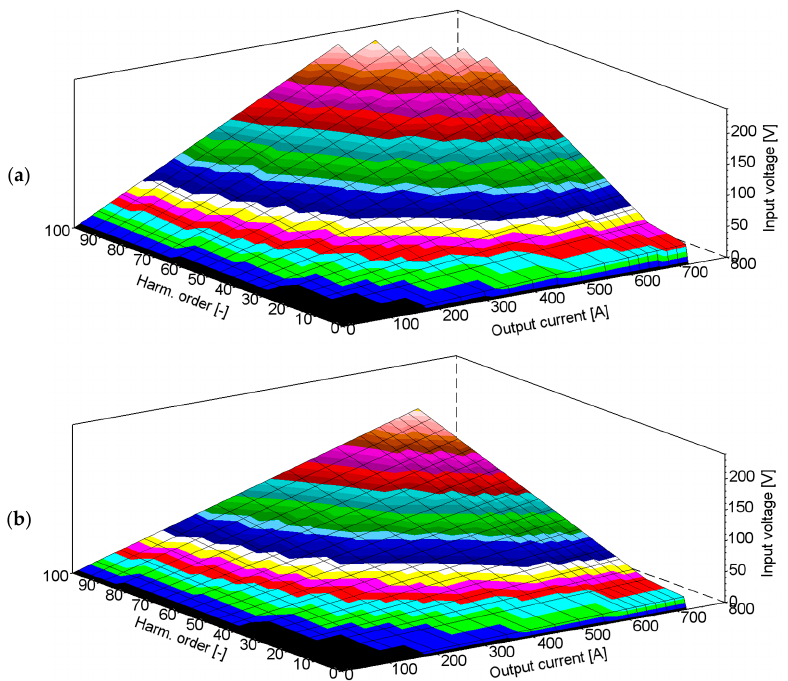
Figure 5. The measured distorted output current with a given harmonic order for the supplied primary voltage obtained for parallel connection of the primary winding’s sections and parallel connection of the secondary winding’s sections: ( a ) R L = 0.3 m Ω ; L L = 3 μ H, ( b ) R L = 0.2 m Ω ; L L = 1.5 μ H.